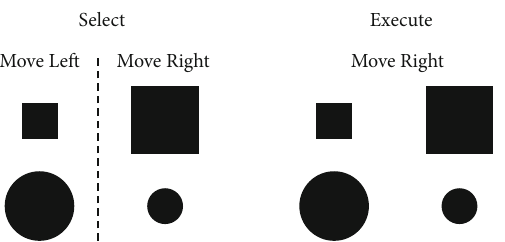
Figure 2: Select and Execute cues used during the brain-behavior probe. During Select, movement direction was dictated by an abstract rule (large square or smallcircle = move right ; small square or largecircle = moveleft ). During Execute, movement direction was the same on every trial regardless of visual cue. The same Select cue set was used in the fi rst arm training